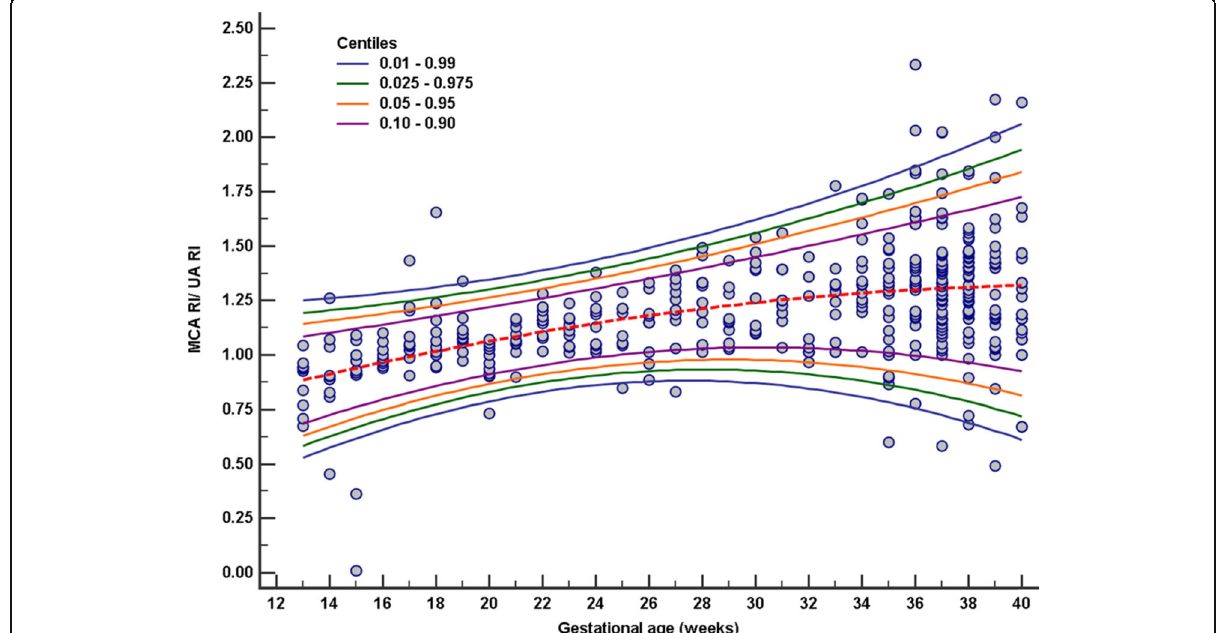
Fig. 3 RI MCA/UA. Scattered diagram of gestational age individual measurement and calculated reference ranges for MCA RI/UA RI in normal pregnancies (1284 observations) with 1st – 99th percentiles (blue lines) and 50th percentiles (red dashed